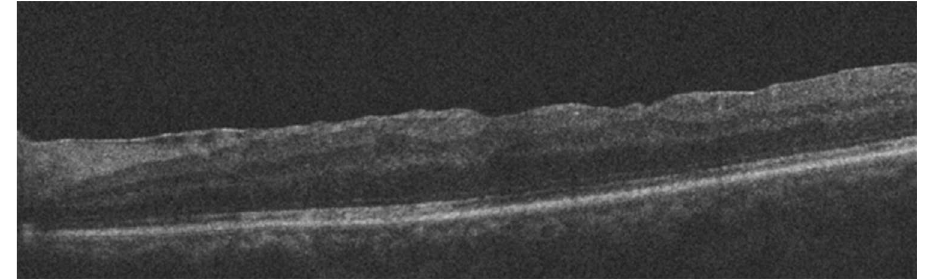
Figure 1. Postoperative OCT image of a case with off-macular